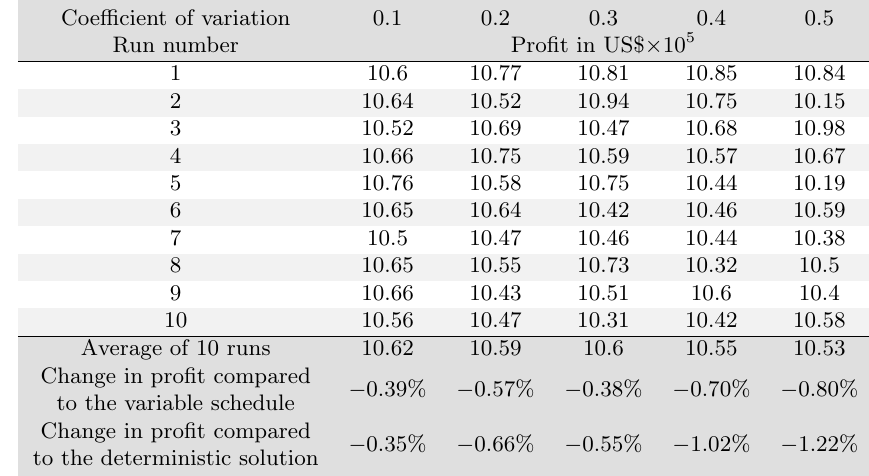
Table 10: The profit for IFPM if a fixed schedule and random catch is used to solve the model.